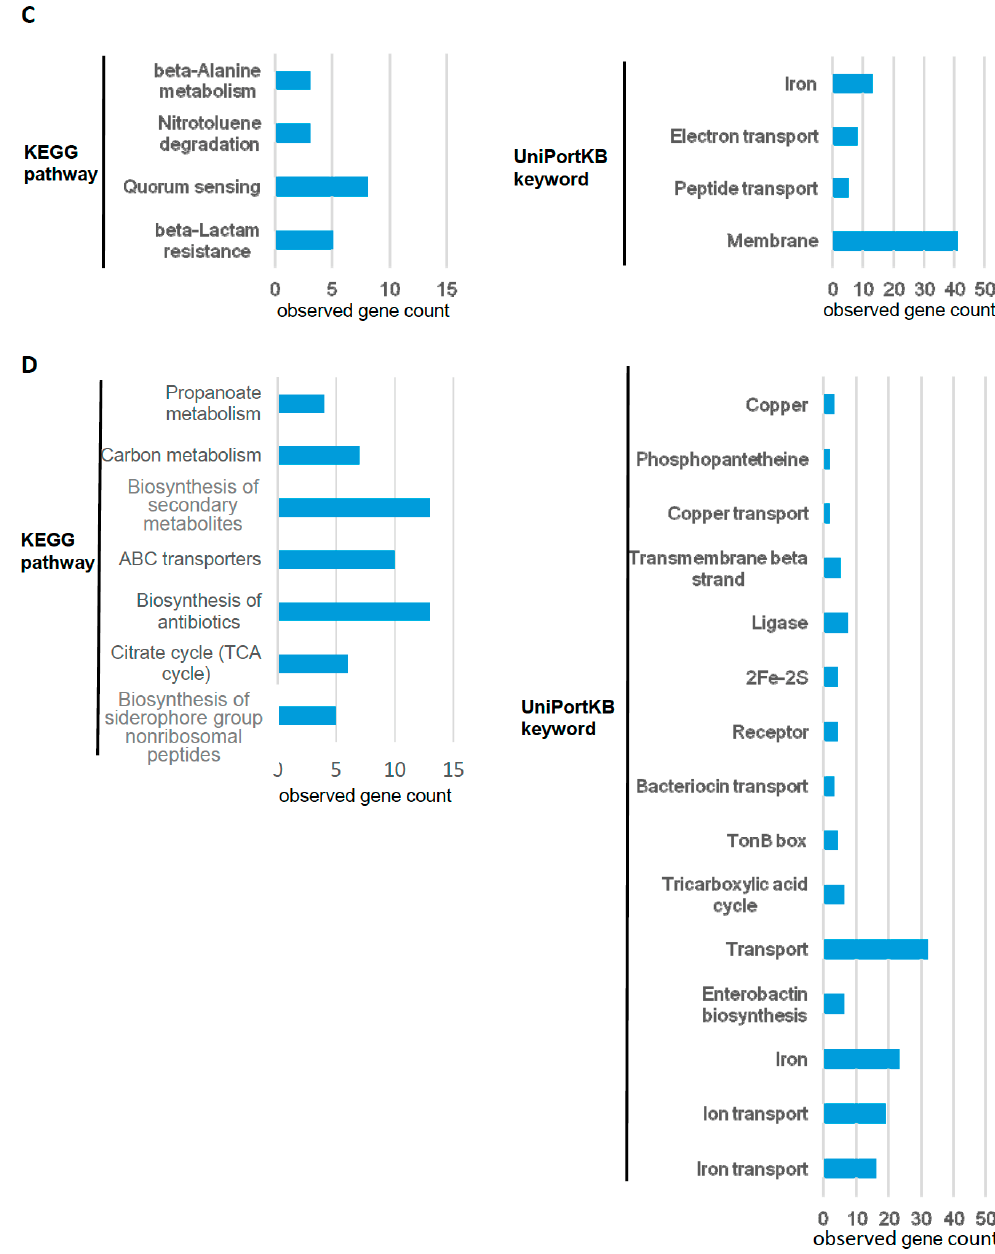
Figure 2. Functional classification of the differentially expressed genes (DEGs). ( A , B ) Gene ontology (GO) enrichment terms were categorized into biological process (BP), cellular component (CC), or molecular function (MF) for upregulated DEGs ( A ) and downregulated DEGs ( B ). Symbol codes for enriched subcategory terms are shown on the y axis, and fold enrichment is presented on the x axis of the horizontal histogram. Numbers of genes for each enriched subcategory are shown to the right of the respective horizontal bar in the histogram. A list of enriched subcategory terms is shown. ( C , D ) Kyoto Encyclopedia of Genes and Genomes (KEGG) pathway enrichment (left panels) and UniProtKB keyword (right panels) analyses were conducted to further classify upregulated ( C ) and downregulated ( D ) DEGs. The enriched term and the respective number of observed genes is shown to the left or right of the histogram, respectively.